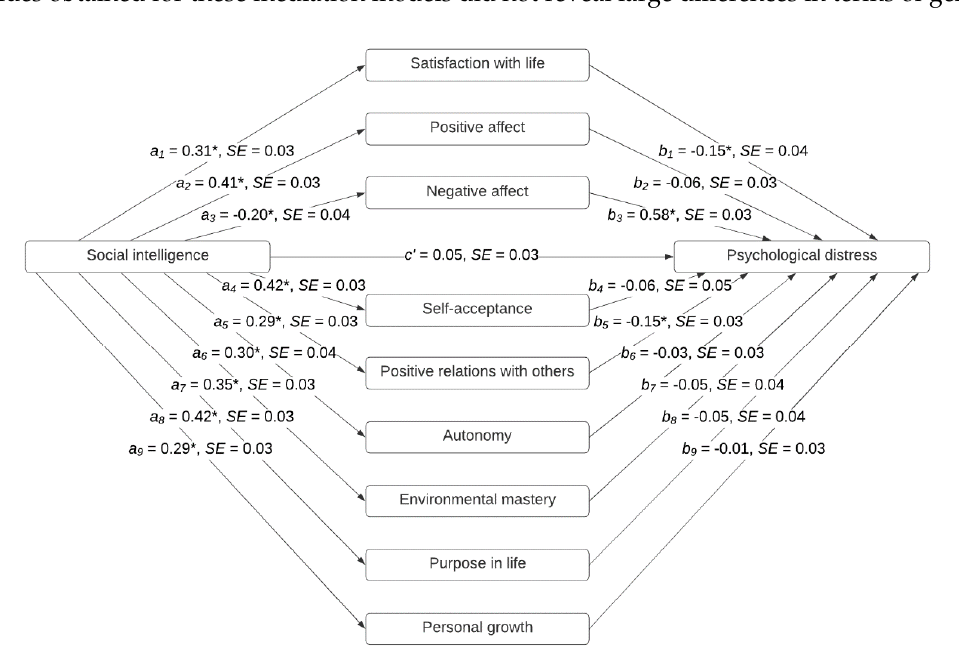
Figure A1. Parallel multiple mediator model of social intelligence, subjective well-being, psychological well-being, and psychological distress for women. Standardized coe ffi cients and standard errors ( SE ) are shown in the figure. * p <